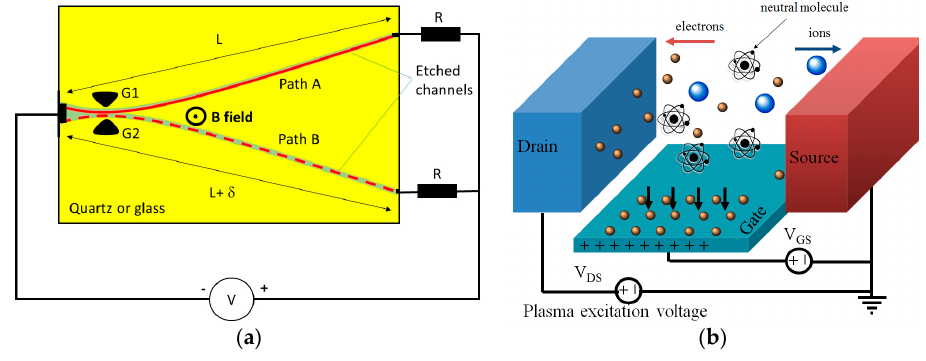
Figure 6. Current control mechanisms used in MPDs. ( a ) A perpendicular magnetic field B is used to switch the plasma between two equivalent paths A and B. ( b ) A positive gate bias sinks the electrons away from the channel region increasing the channel breakdown voltage and a negative gate bias would push electrons into the channel region reducing the channel breakdown voltage [25].